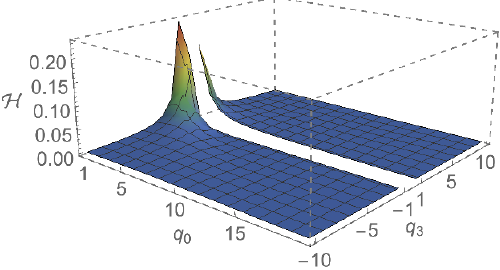
Figure 7 . The entropy parameter H as a function of the charges of V, q 0 and q 3 with k 1 , (cid:0) k 2 , k 3 are equal to 1 and Q